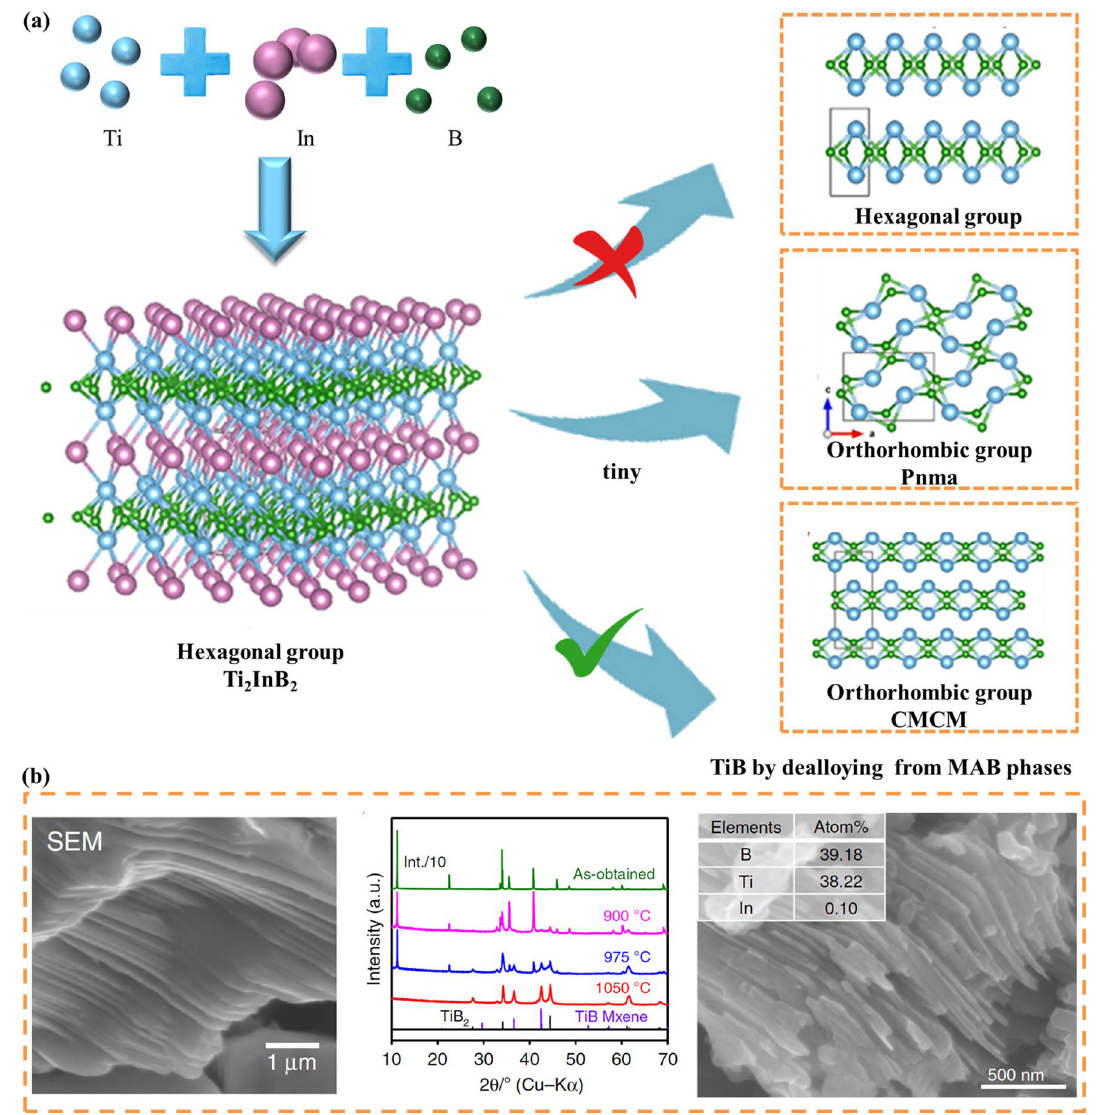
Fig. 5 a Proposed the generated crystal structures from the parent Ti 2 InB 2 phase by dealloying. b Left: SEM image of a particle showing a laminated structure. Middle: XRD patterns for samples prepared by exposure of as-obtained Ti 2 InB 2 powder to a vacuum (about 10 −4 Pa) as a function of the temperature after 6 days. Right: Typical SEM image of the TiB phase; inset shows the atomic ratio for this sample. Reproduced with permission from Ref.